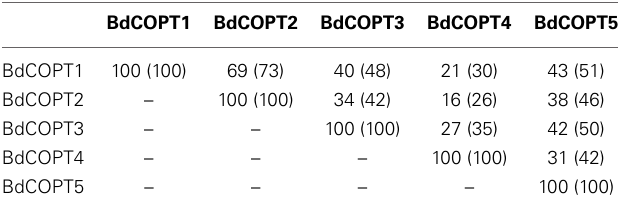
Table 2 | Percentage of amino acid identity (similarity) among putative COPT proteins in